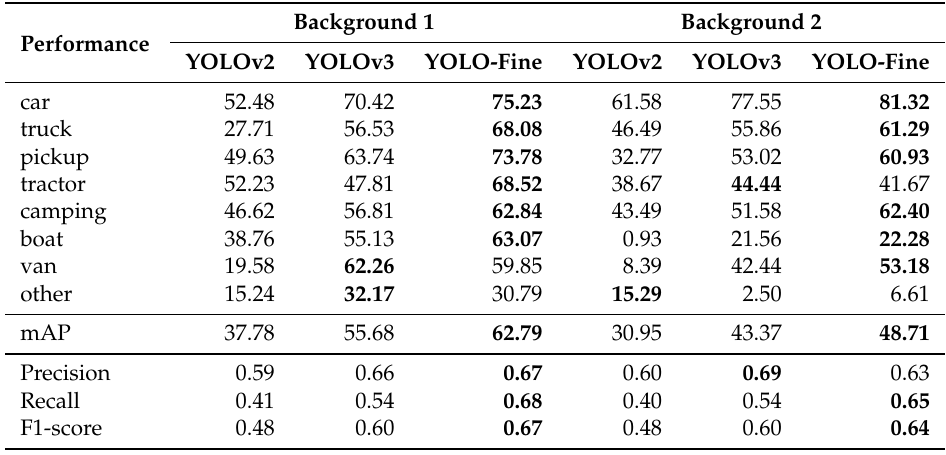
Table 10. Performance of YOLO-fine as compared to YOLOv2 and YOLOv3 on detection of known objects with the appearance of new backgrounds in validation sets: the first background contains residential/semi-urban areas and the second background very dense urban areas. Best results in